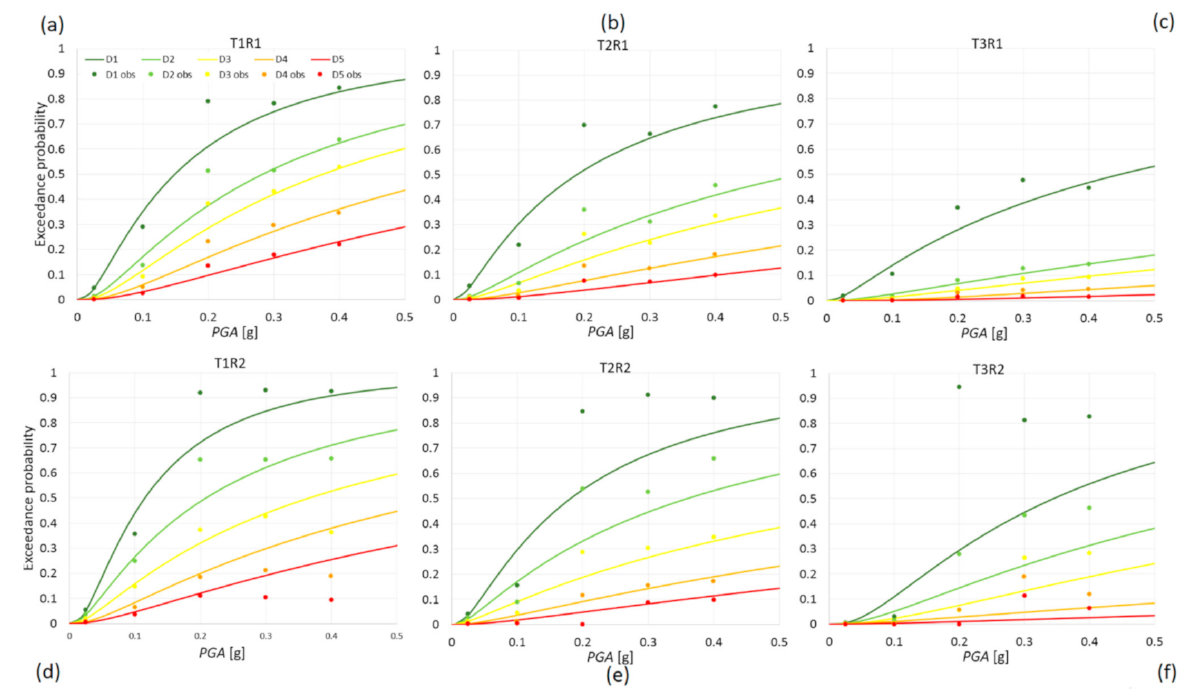
Figure 4. Fragility curves fitting the observed damage data for typological classes: ( a ) T1R1, ( b ) T2R1, ( c ) T3R1, ( d ) T1R2, ( e ) T2R2, and ( f ) T3R2.